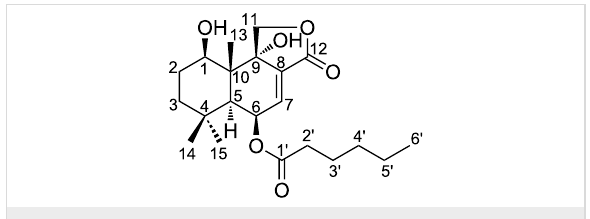
Figure 1: Structure of SF002-96-1.